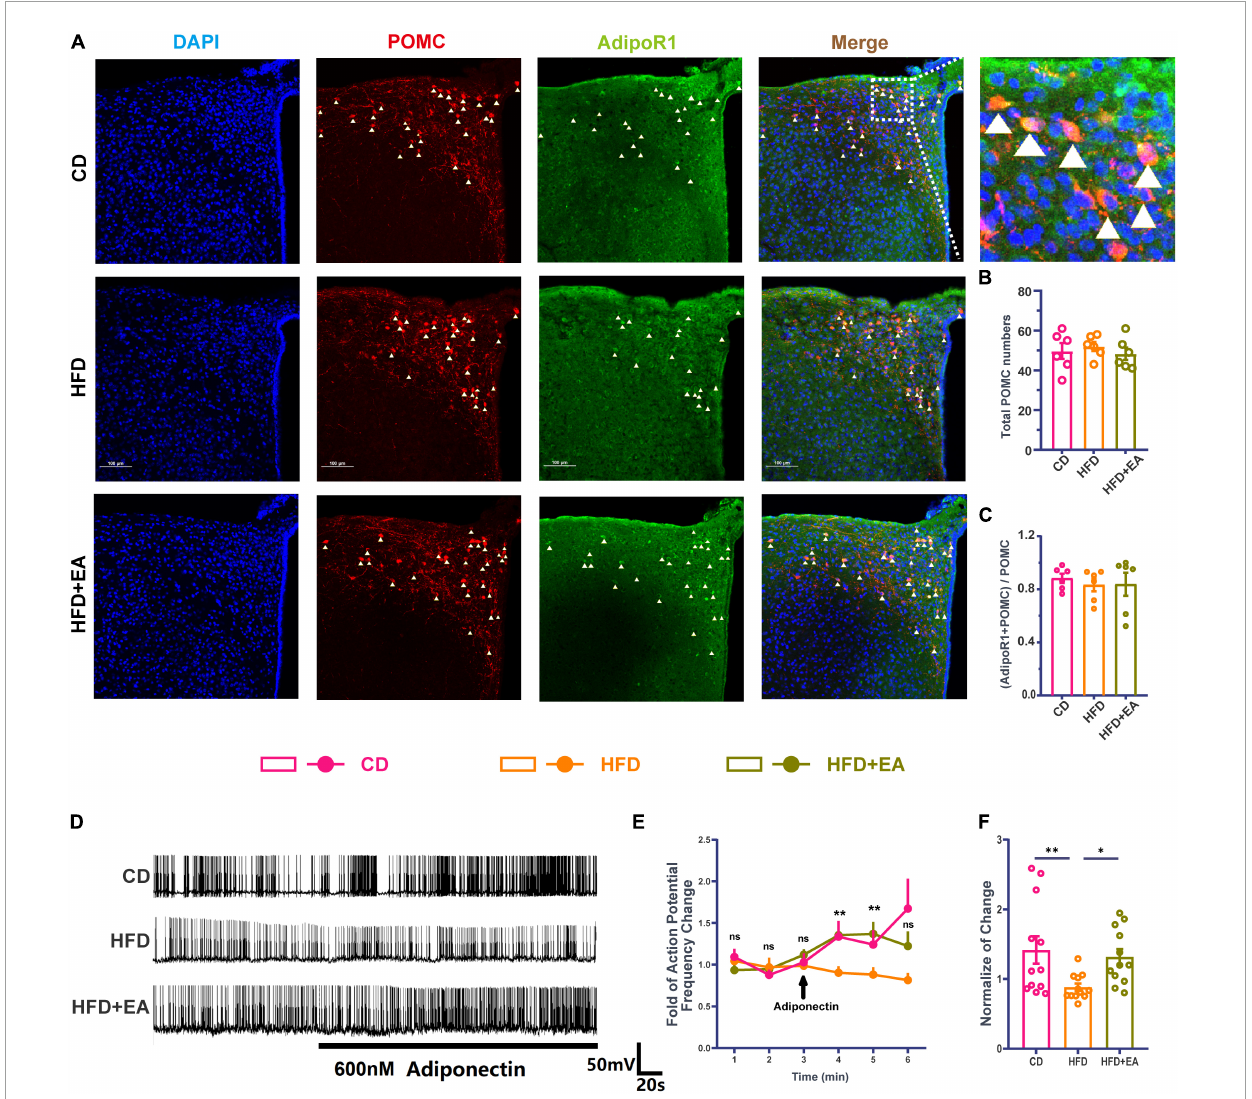
FIGURE4 EA treatments activate hypothalamic POMC neurons’ response to Adipo. (A) Co-labeled immunofluorescence representation of POMC neurons and AdipoR1 in the arcuate nucleus of the hypothalamus. (B) Total POMC numbers. (C) Ratio of common standard count of POMC neurons and AdipoR1 in the total POMC number. (D) Frequency representation of spontaneous action potential of POMC neurons before and after Adipo perfusion. (E) Spontaneous action potential frequency line diagram of POMC neurons before and after Adipo perfusion. (F) Normalization of action potential frequency change. “n” in the immunofluorescence graph represents the number of slices, with 3 mice in each group. “n” in the patch clamp graph represents the number of cells (the number of mice in each group ≥ 3). Panel (E) shows the statistical results of HFD group and HFD + EA group. CD: control group. HFD: high-fat diet group. HFD + EA: model + electroacupuncture group. ns P > 0.05; ∗ P < 0.05; ∗∗ P < 0.01 (one-way analysis of variance with post hoc Bonferroni correction or Tamhane correction). Scale bars: 100 µ